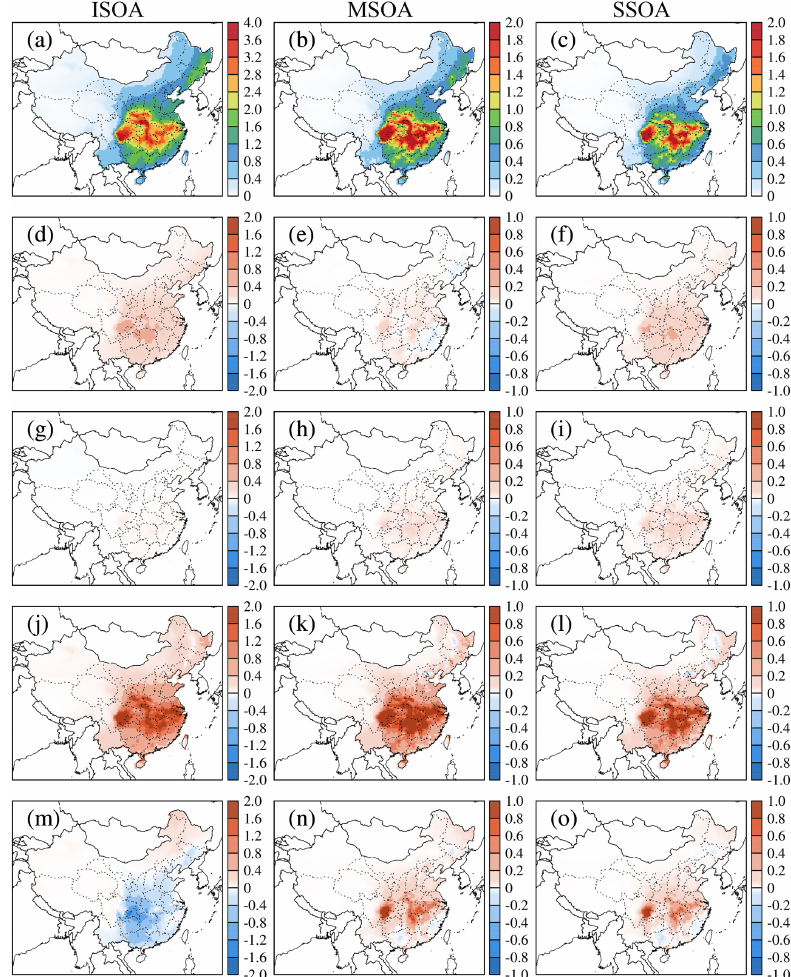
Figure 8. Spatial distributions of simulated SOA from isoprene (ISOA), monoterpenes (MSOA), and sesquiterpenes (SSOA) in the different cases in summer. (a–c) C1, (d–f) C1–C2, (g–i) C1–C3, (j–l) C1–C4, and (m–o) C1–C5). Unit is micrograms per cubic meter of